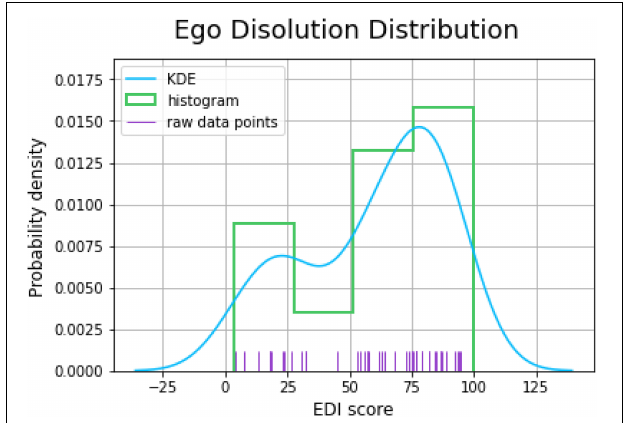
FIGURE 4 | Probability distribution plot of the experience of ego dissolution as assessed by the EDI morning after the psilocybin ceremony. The plot depicted kernel density estimation (KDE), histogram, and raw data